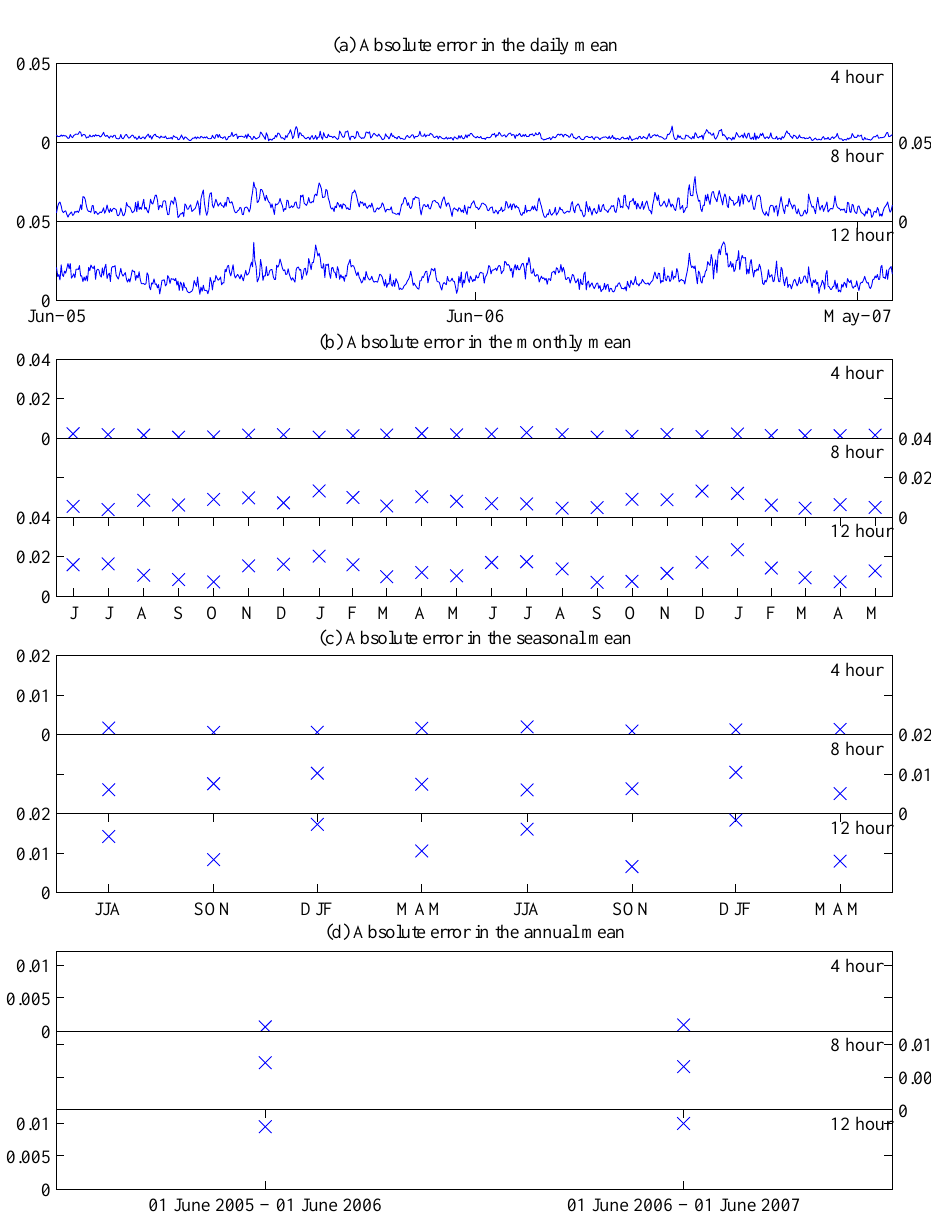
Figure 4. All panels ( a – d ) as for Figure 3 but showing just δ r , n